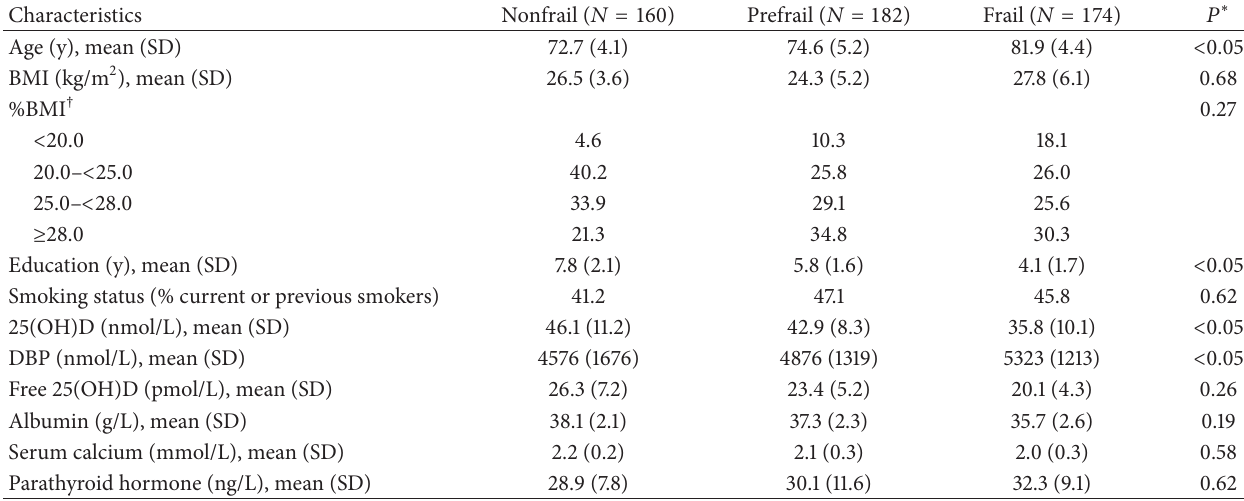
Table 2: Selected demographic and study variables of the study sample across frailty